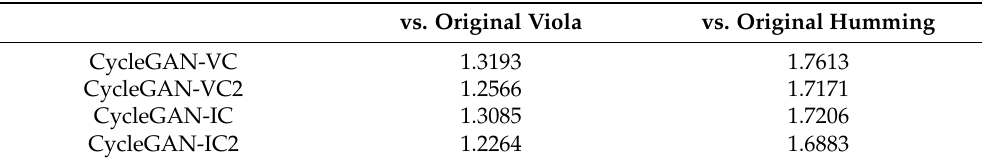
Figure 3. The box plots of ( a ) RMSE and ( b ) MCD for testing set MIR-QBSH-3 in humming to viola. Table 2. The average RMSE of the converted viola with the original viola/humming.